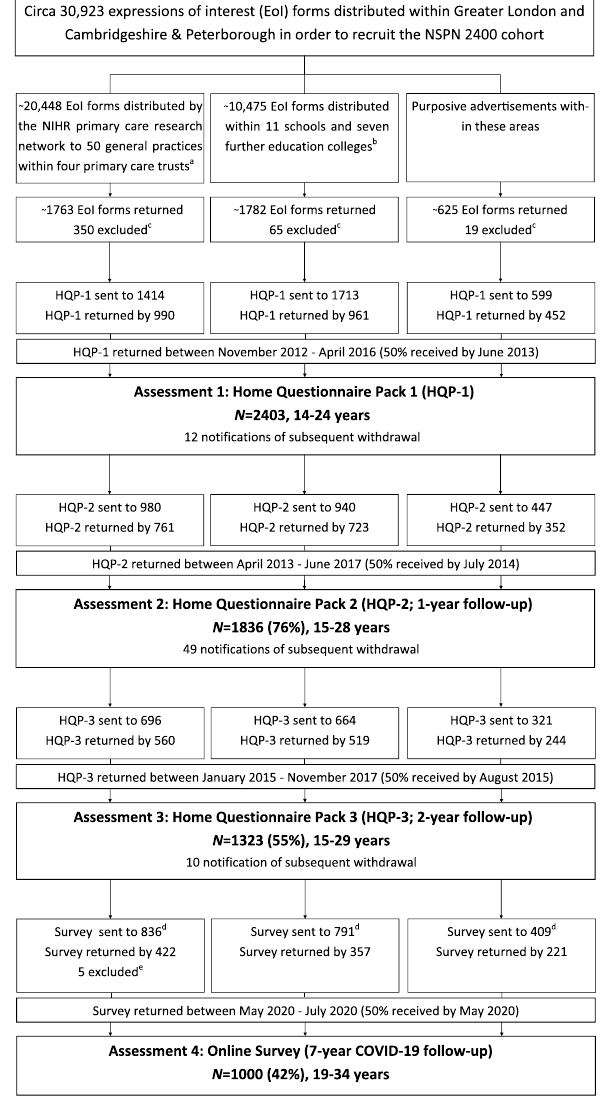
Figure 1. STROBE diagram illustrating the recruitment stages of the NSPN 2400 cohort; adapted from Kiddle et al. (2018). Eol expression of interest, HQP home questionnaire pack; superscript a: 36 practices in Cambridgeshire and Peterborough Primary Care Trust (PCT), 8 in Barnet PCT, 3 in Camden PCT and 3 in Islington PCT; superscript b: schools in Barnet (2), Camden (4), Islington, Tower Hamlets, Haringey, Lambeth and Redbridge (all 1 each), and colleges in Cambridgeshire and Peterborough (6) and Islington (1); superscript c: excluded due to current age beyond scope; superscript d: Assessment 4 was designed as an online survey for which all baseline participants who (a) had a valid email address, and (b) had not withdrawn consent in previous assessments, have been invited (note that for previous assessments only participants who took part in the preceding assessment were invited); superscript e: excluded due to uncertainty of survey responder